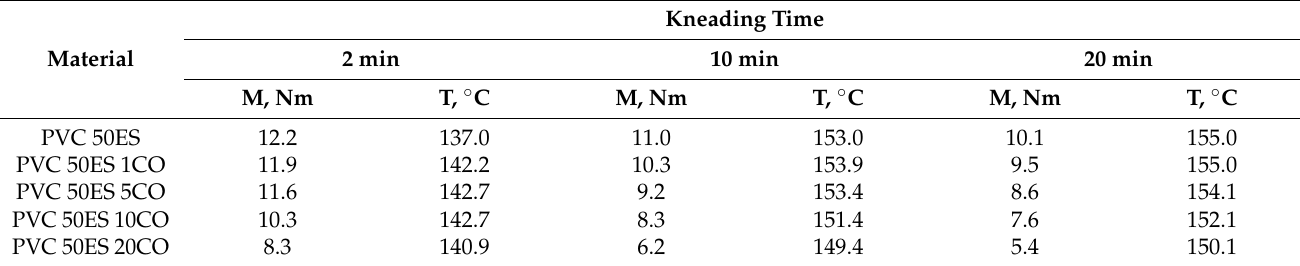
Table 1. Analysis of plastographometric characteristics.